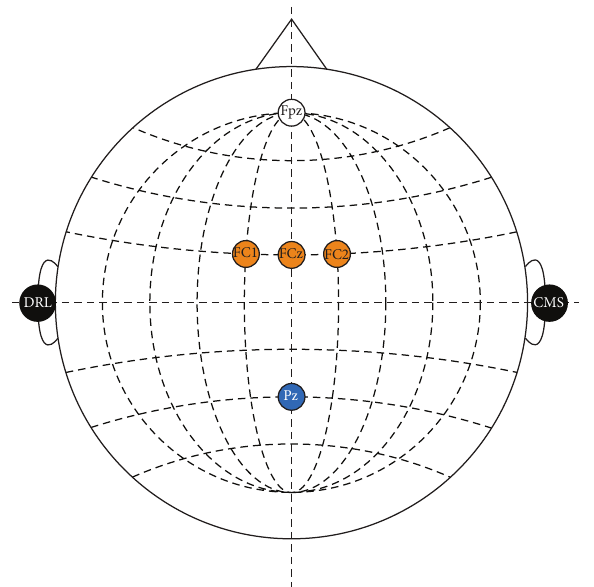
Figure 7: Channel set of 5 fixed channels built from the channels that were most frequently selected by the proposed algorithm.